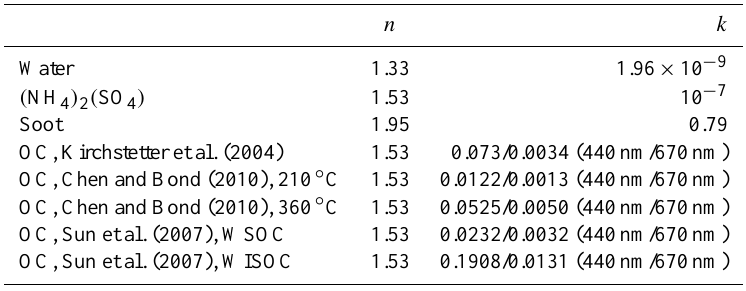
Table 1. Refractive index values of the components, real part (n) and imaginary part (k) . All the components are assumed to be spectrally constant, except for OC whose imaginary index at 440nm and 670nm is by Kirchstetter et al. (2004) and zero at 870nm and 1020nm. Shown are also the imaginary index values for OC, based on Chen and Bond (2010) and Sun et al. (2007), that were used to assess the sensitivity of the OC retrieval for the assumed imaginary index.